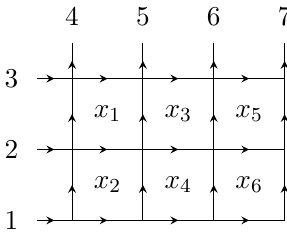
Figure 2 . The 10 vertices and 15 edges of the full Tr(2 ; 5) space. The highlighted star is the positive region. It corresponds to the canonical order amplitude of the scalar bi-adjoint (cid:30) 3 theory.